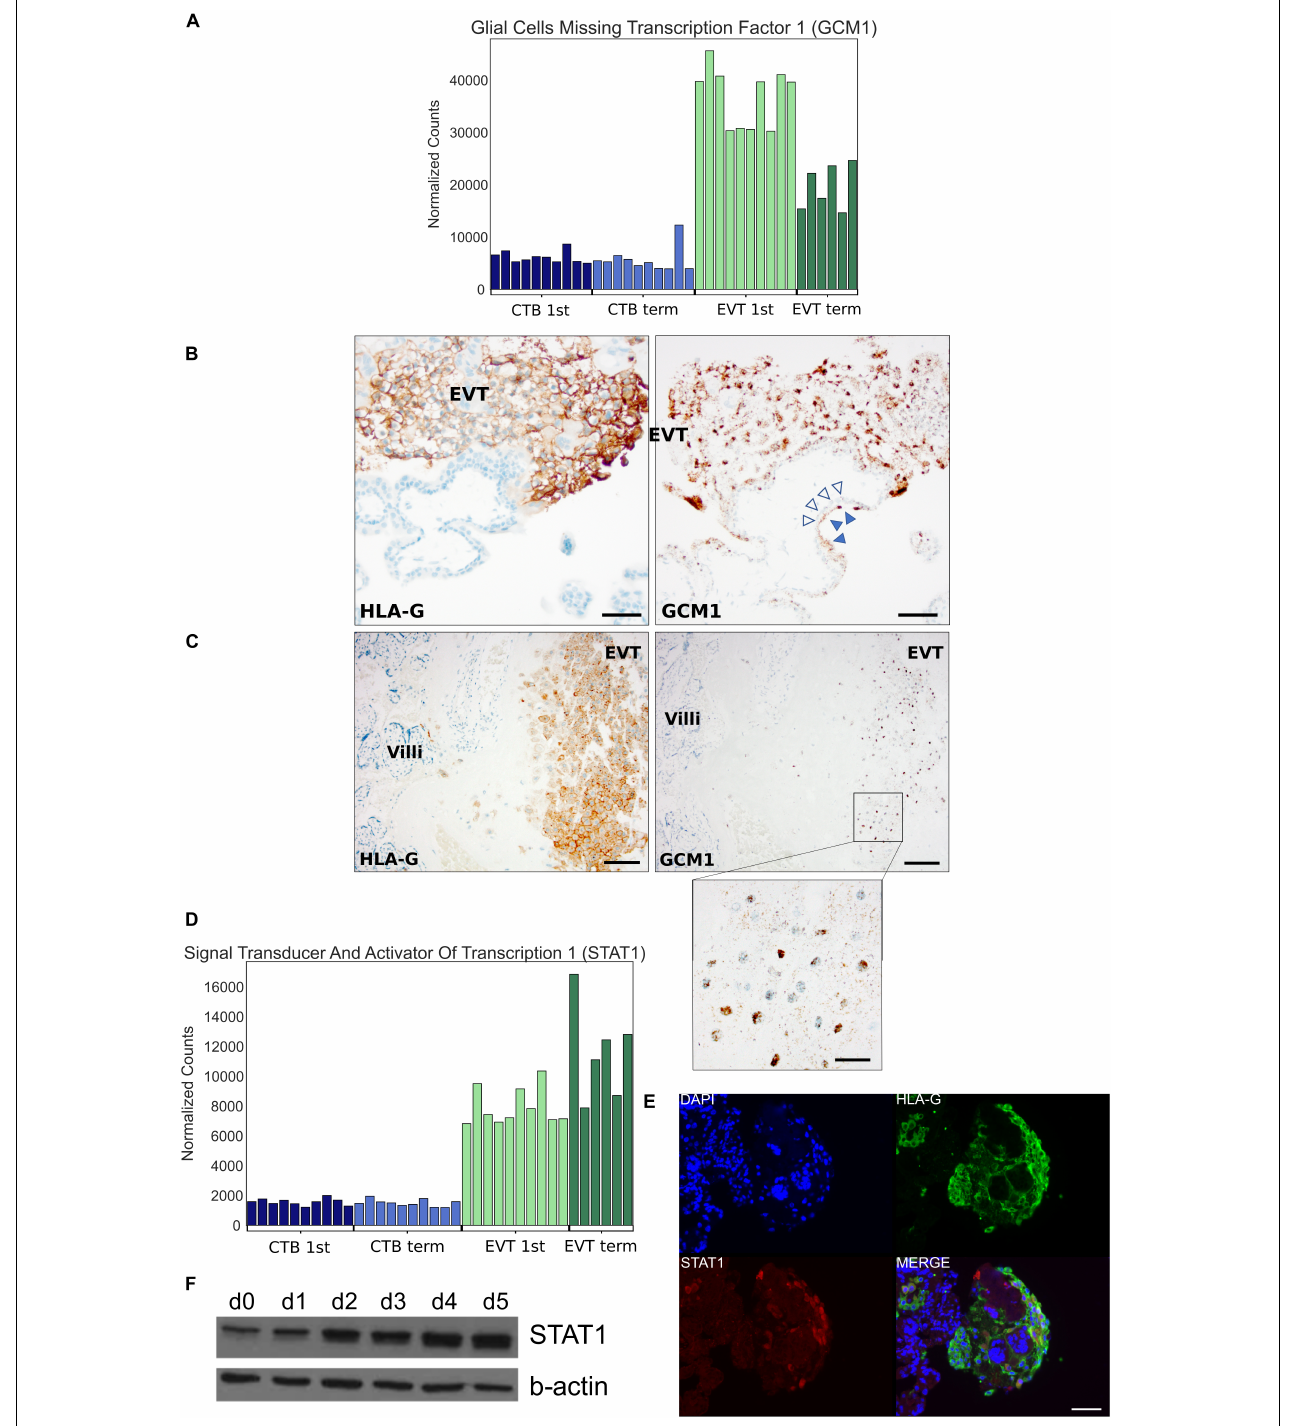
FIGURE 9 | Localization and expression of GCM1 and STAT1 transcription factors. (A) Bar graph depicting GCM1 expression in all 36 placental samples using RNA-seq. (B) In situ hybridization of GCM1 (right-side) and immunohistochemistry for HLA-G (left-side) in adjacent sections of first trimester EVT. Empty arrowheads point to CTB and filled arrowheads to syncytiotrophoblast, which also expresses GCM1. HLA-G staining highlights EVT. Scale bars = 50 µ m. (C) In situ hybridization of GCM1 (right-side, with further magnification in inset) and immunohistochemistry for HLA-G (left-side) in adjacent sections of term EVT. HLA-G again highlights EVT at the basal plate. Scale bar = 100 µ m in main panels and 25 µ m in inset. (D) Bar graph depicting STAT1 expression in all 36 placental samples using RNA-seq. (E) Immunostaining of first trimester placenta with antibodies against HLA-G and STAT1 and counterstained with DAPI. Scale bars = 50 µ m. (F) Western blot of STAT1 and beta-actin (control) during EVT differentiation of 1049 hTSC